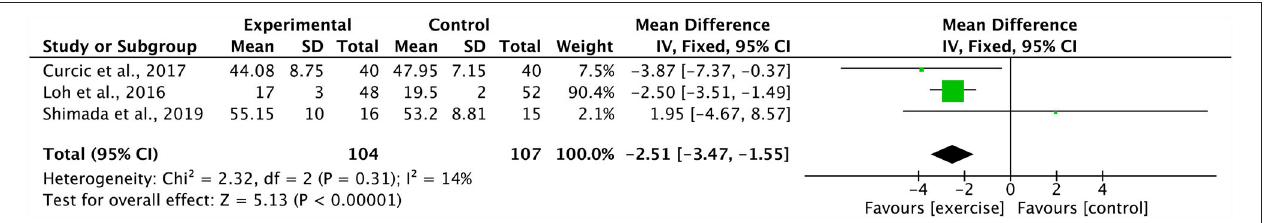
recumbent bike, rowing machine, cross trainer, resistance